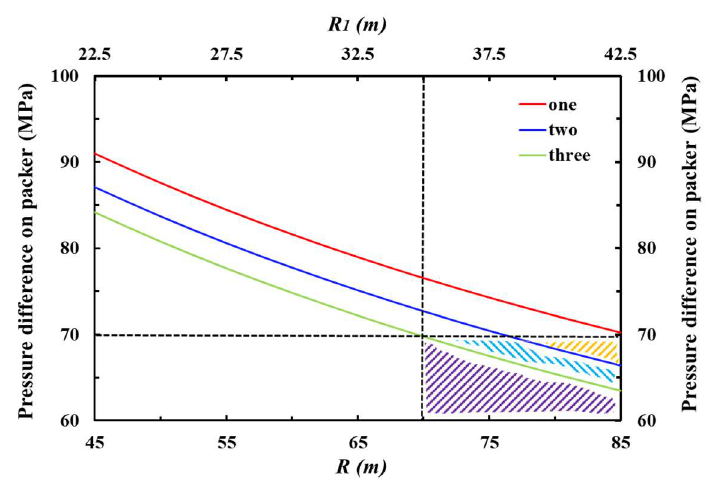
Figure 16. Field case optimization design.